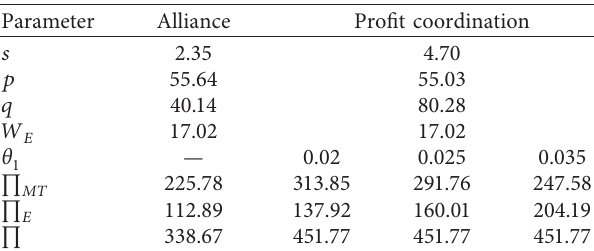
Table 5: Coordination results of revenue sharing in semi- centralized model